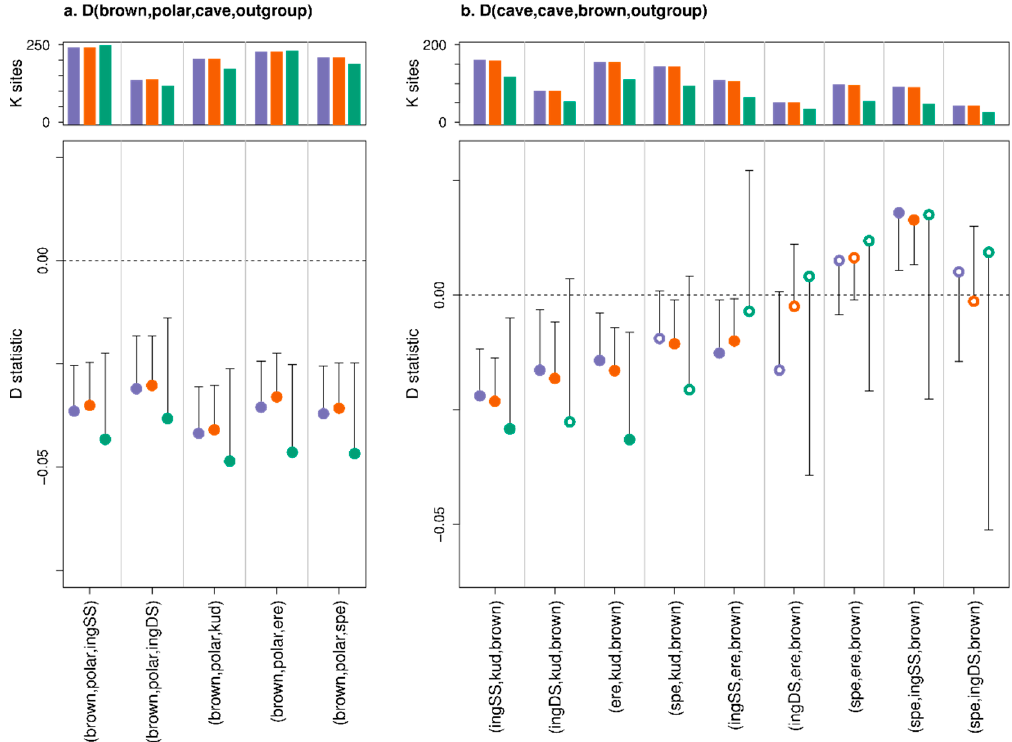
Figure 6. Effect of Consensify on D statistic tests of admixture among cave bears and brown bears subsequent to the divergence of polar bears and brown bears ( a ), and subsequent to the divergence of the sampled cave bear populations ( b ). The plot layout and annotation are consistent with Figures 4 and 5. The polar bear and brown bear lineages are each represented by a single individual (SRS412584 and 191Y Slovenia, respectively). Comparisons are described by x axis labels, with either the first three letters of each cave bear taxon, or “polar” for the polar bear and “brown” for the brown bear, indicating their respective positions as (P1,P2,P3). The outgroup (P4) is the Asiatic black bear. Note that y axes are not consistent between panels ( a and b ).